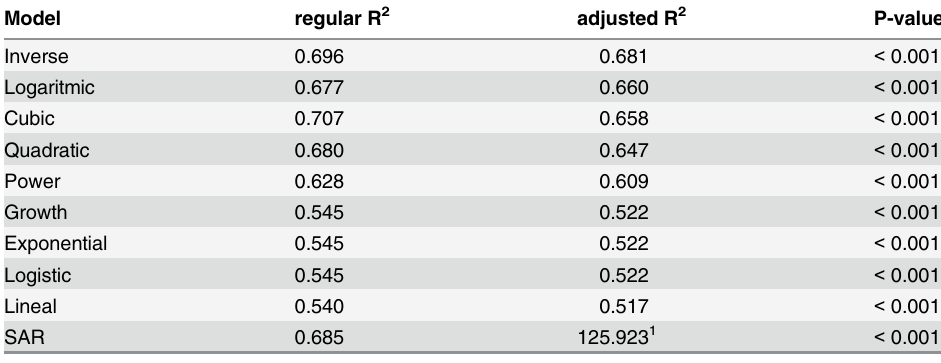
Table 2. Goodness-of-fit of the regression models between Mahalanobis distance to the ENC and bur- row abundance of Gopherus flavomarginatus .